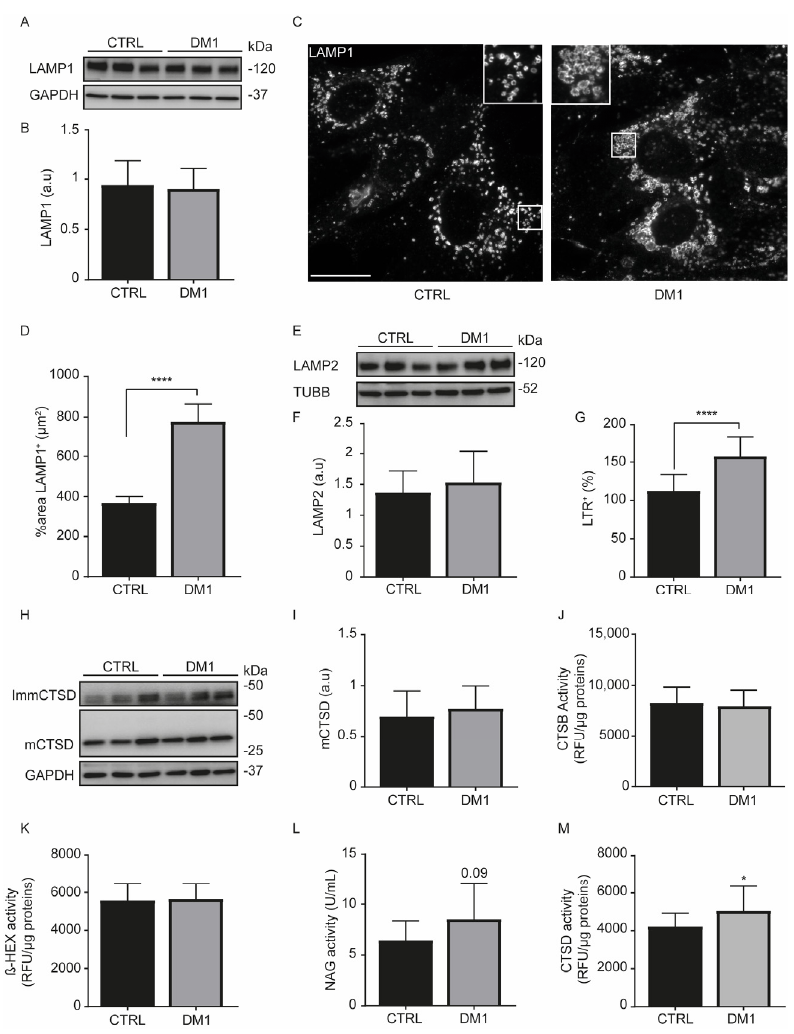
Figure 4. Lysosomal size and cathepsin D activity are increased in DM1 cells. ( A , B ) Protein ex- pression levels of LAMP1 were detected by immunoblotting and its densitometry normalized to GAPDH, (a. u, arbitrary units). Data correspond to the mean ± SD of three replicates. ( C ) CTRL and DM1 cells were immunolabeled with LAMP1 antibody. Lysosomes were detected in human fibro- blasts by confocal microscopy (original magnification ×60, scale bar is 10 µm). ( D ) The % area oc- cupied by LAMP1 positive structures was determined with ImageJ software ( n = 100 cells/condition). Data are the % area ± SEM (**** p < 0.0001, with Student’s t -test). ( E , F ) Expression levels of LAMP2 were detected by immunoblotting and its densitometry normalized to α -Tubulin (TUBB). ( G ) CTRL and DM1 cells were stained with 100 nM lysotracker red (LTR). The percentage ± SD of LTR + signal was detected by flow cytometry, n = 10,000 events. Data are the mean ± SD of four replicates (**** p < 0.0001 with Student’s t -test). ( H , I ) Protein expression levels of cathepsin D (CTSD) were detected by immunoblotting. CTSD antibody detects mature (mCTSD) and immature CTSD (ImmCTSD) forms ( H ); the densitometry of mCTSD was normalized to GAPDH. Data are the mean ± SD of three replicates ( I ). ( J – M ) Lysosomal enzyme activities were determined by fluo- rimetric ( J , K , M ) or colorimetric ( L ) assays. Cathepsin B (CTSB) ( J ), β -Hexosaminidase ( β -HEX) ( K ), and CTSD ( M ) activities are presented in relative fluorescence unit (RFU)/µg proteins, (* p < 0.05 with Student’s t -test). N-acetyluglucosaminidase (NAG) activity is in U/mL ( L ). Each group (CTRL or DM1) consisted of three cell lines. All experiments were performed at least three times. 3.4. Defect in Fluorescent EGF Binding and Delay of EGFR Degradation in DM1 Cells Endosomes (Figure 3C) and lysosomes (Figure 4C) are enlarged in DM1 cells when compared with CTRL cells; therefore, we examined their impact in the degradative en- docytic pathway by incubating fibroblasts with Alexa-555-EGF (555-EGF) for 30 min on